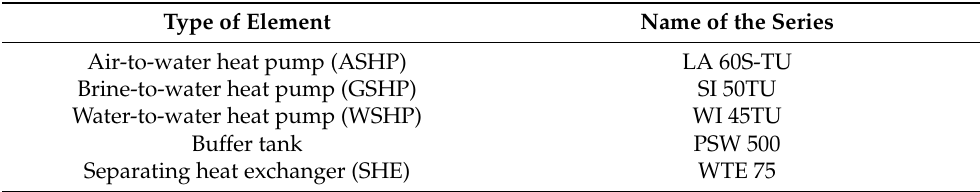
Table 1. Types of compared heat pumps and supplementary devices manufactured by the Dimplex company.